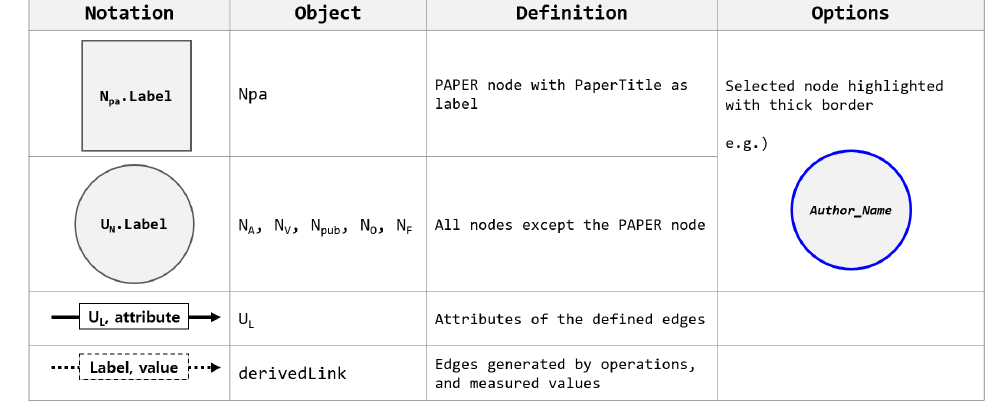
Figure 9. Notations for Visualization. Tool.